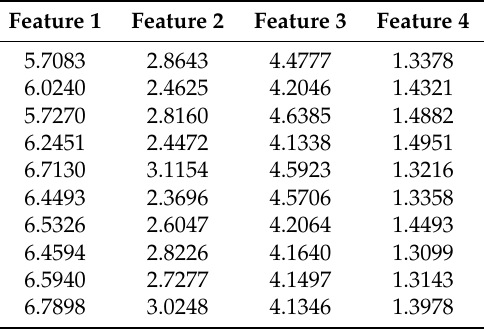
Table 11. Ten virtual samples